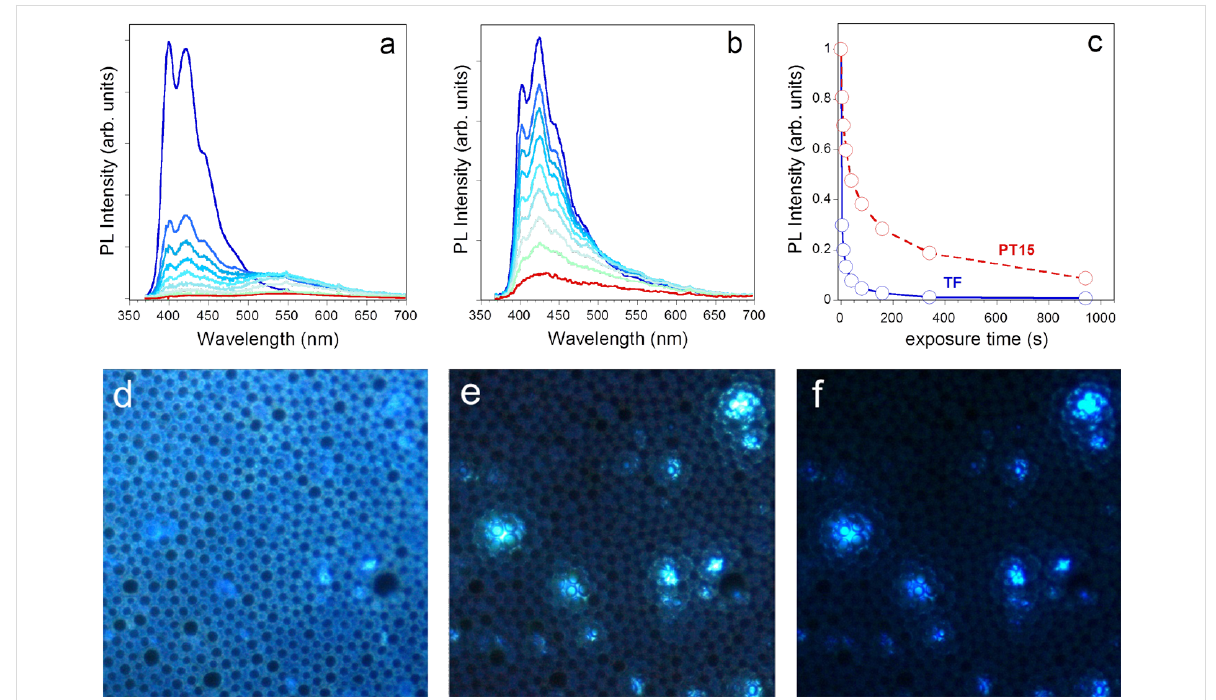
Figure 6: Chromatic stability of steady-state PL spectra upon UV exposure for 0 (dark blue line) to 20 min (red line) of neat flat TF film (a) and PT15 film (b). PL intensity of 400 nm peak of TF and PT15 film versus exposure time to UV light (c). PL images of the patterned PT15 film acquired during exposure to UV light are reported in